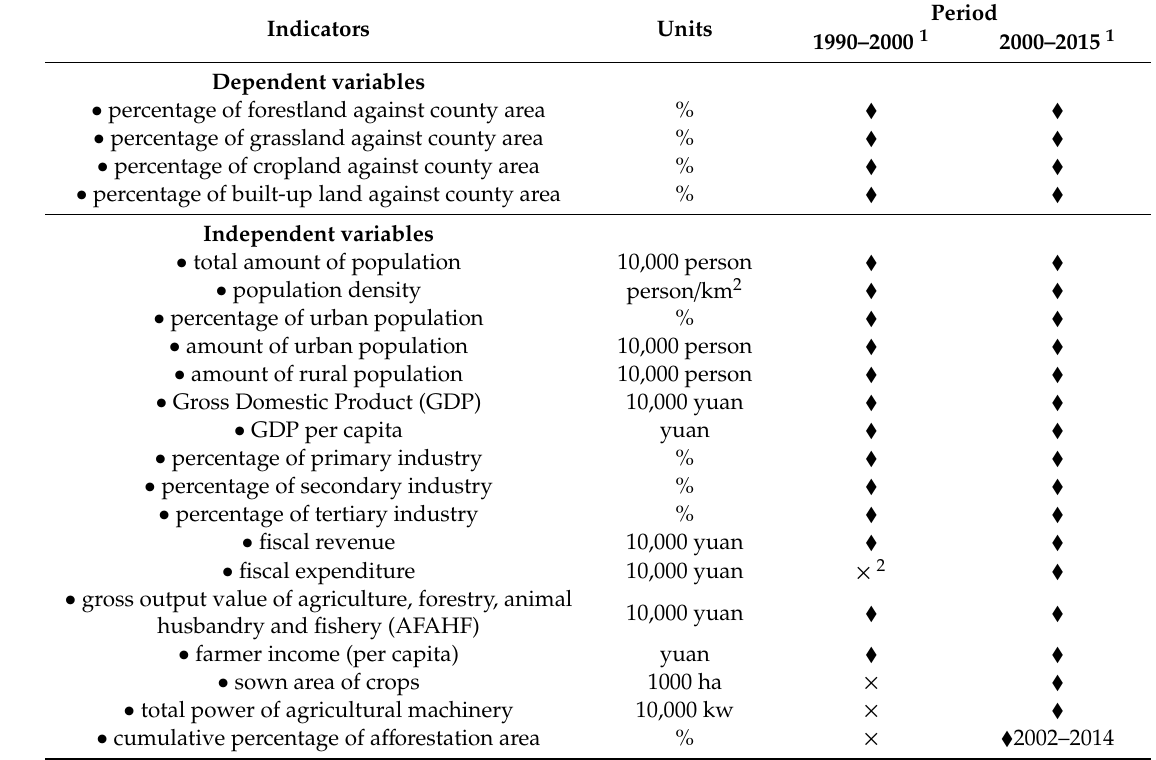
Table 2. Indicators of dependent and independent